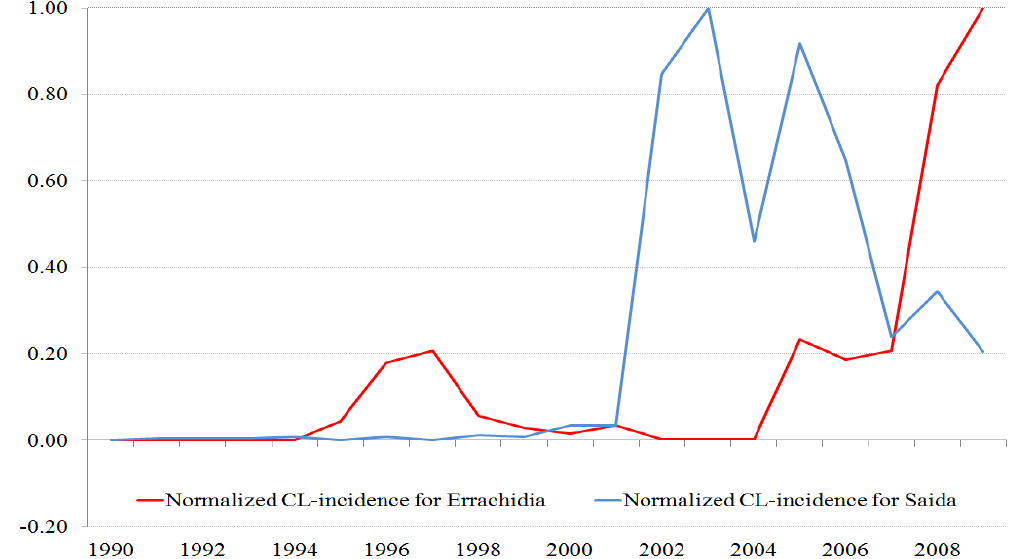
Figure 2. Normalized time series of ZCL-cases for the two provinces. The maximum number of cases for Saida is 267 (population 7,500 inhabitants) and for Errachidia is 1596 (population 600,000